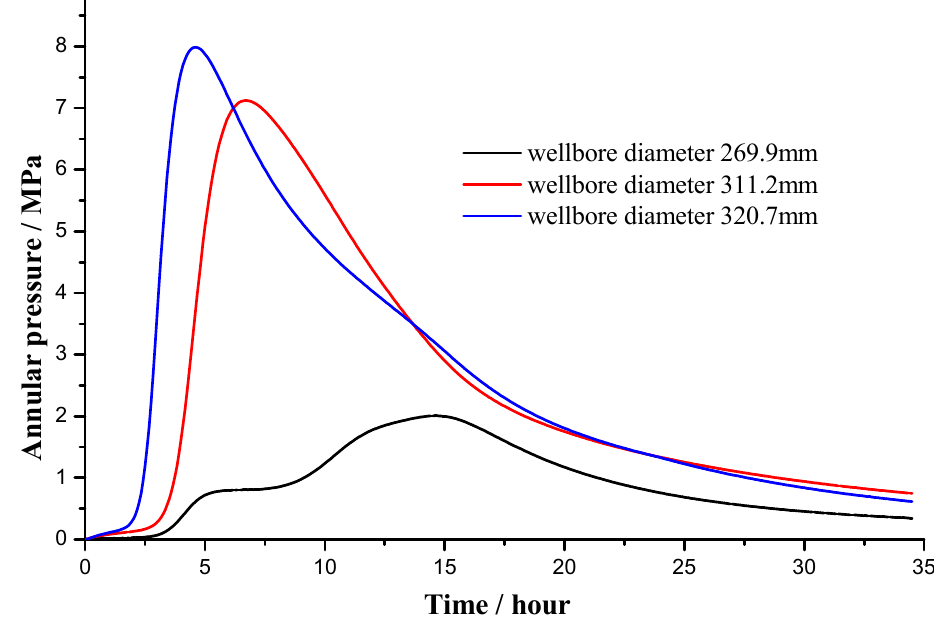
Figure 14. Annular pressure under different wellbore diameters.